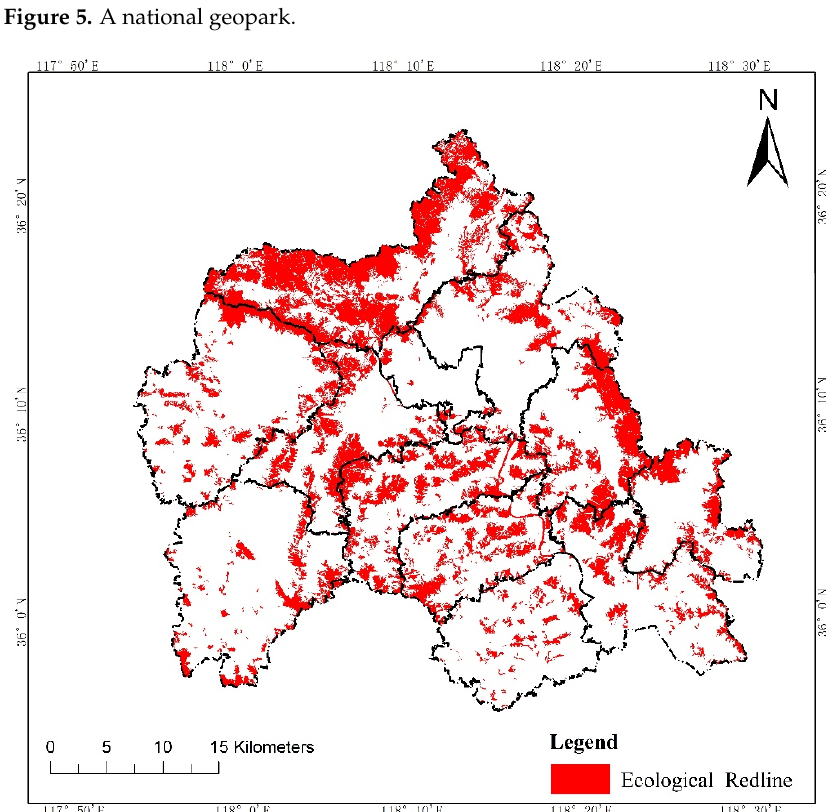
Figure 5. A national geopark.